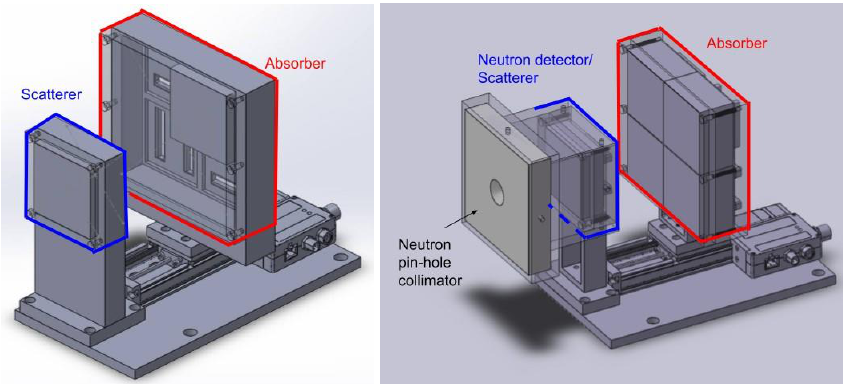
Fig. 1. Technical implementation of the i-TED Compton camera (left) and evolution towards the proposed GN-Vision device (right). The main components of both devices have been highlighted. The dimensions are indicated in Table